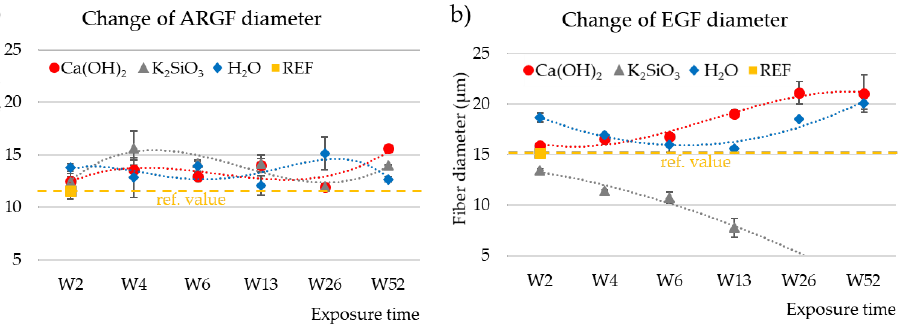
Figure 7. Changes in fiber diameter as a function of exposure time in different solutions: ( a ) ARGFs, and ( b ) EGFs. The points represent the average of measured values for the fiber diameter, and the lines represent the trend lines. The reference value for ARGFs fibers is 11.62 ± 0.84 µ m and for EGFs fibers is 15.18 ± 0.17 µ